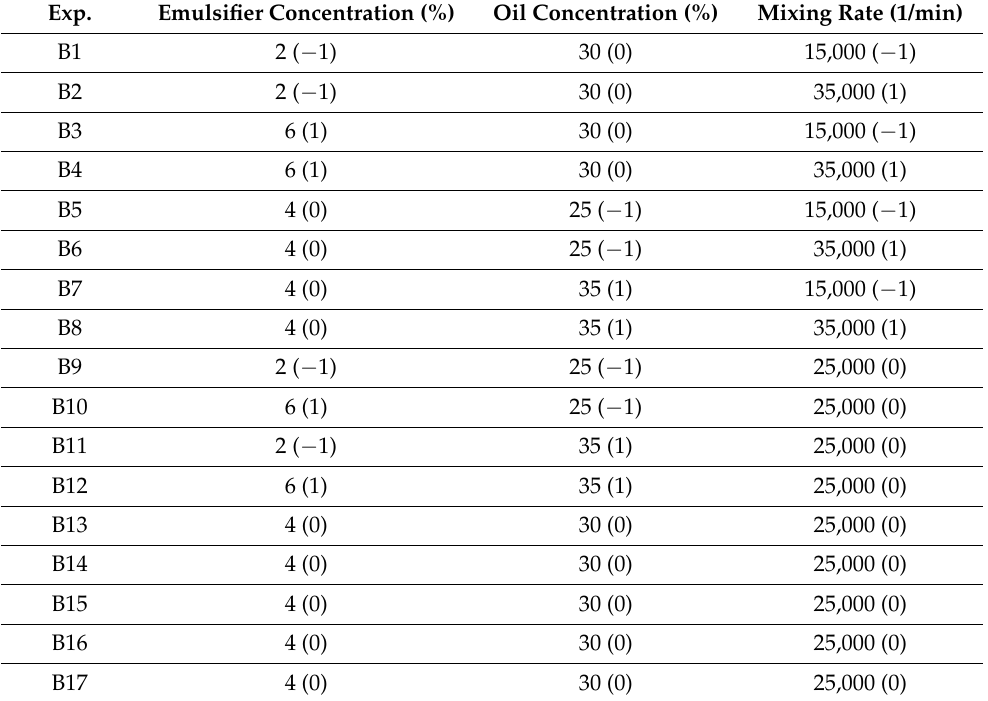
Table 1. Experimental plan for emulsion production in a batch system.